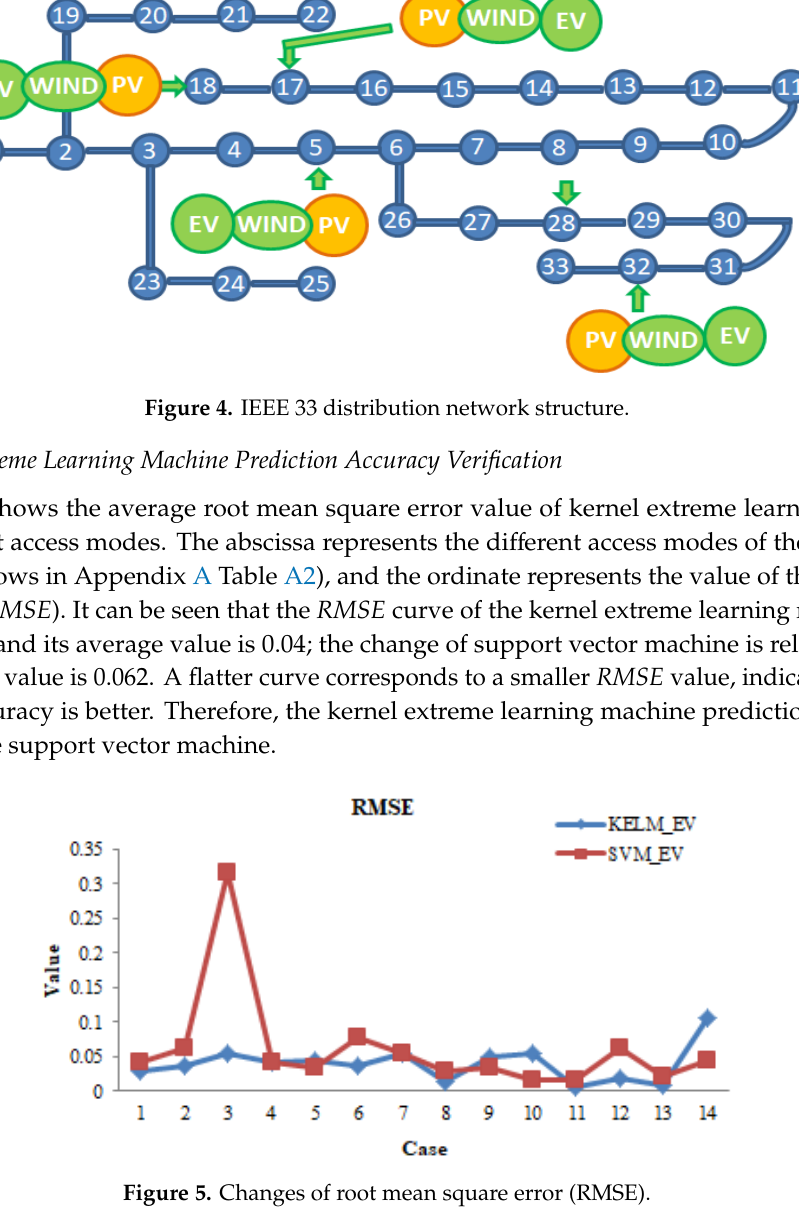
Figure 4. IEEE 33 distribution network structure;